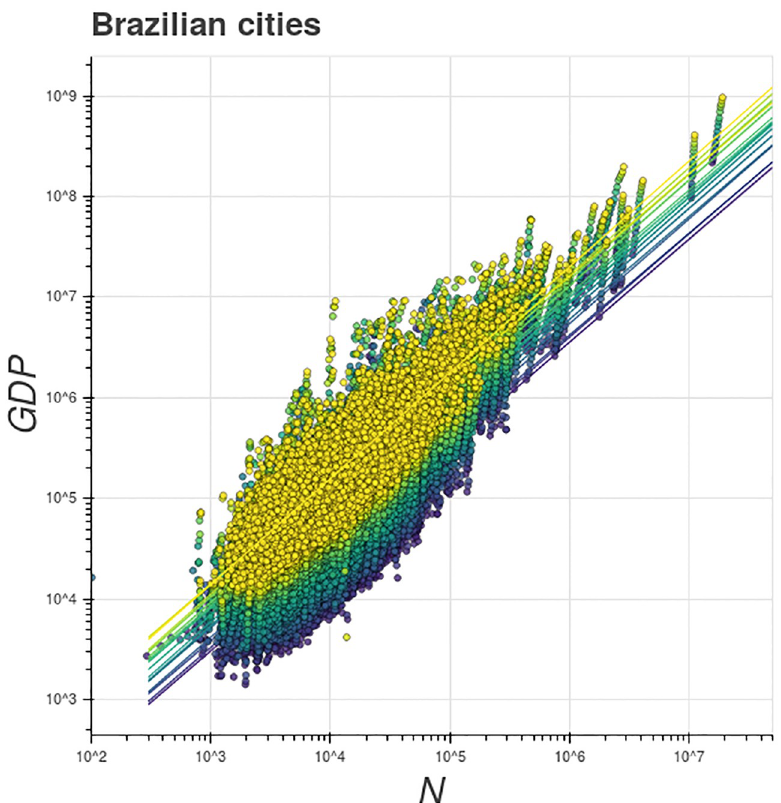
Fig 1. Transversal scaling of GDP. Scaling relation between population and GDP of Brazilian cities, from 1998 (blue) to 2014 (yellow). The straight lines are the best power-law equation fits for each year (by the maximum likelihood method). The straight lines are virtually parallel, which shows that the transversal scaling exponent is constant and robust. The scaling exponent is always greater than 1 for all years, with a mean � b ¼ 1 : 04 . It reveals a superlinear T scaling property, compatible with the fact that the GDP is a socio-economic urban variable. The numeric time evolution of the transversal scaling exponent and the intercept parameter are shown in Fig